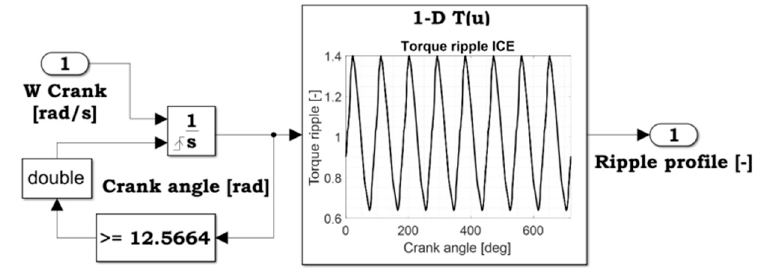
Figure 10. Torque ripple simulation.